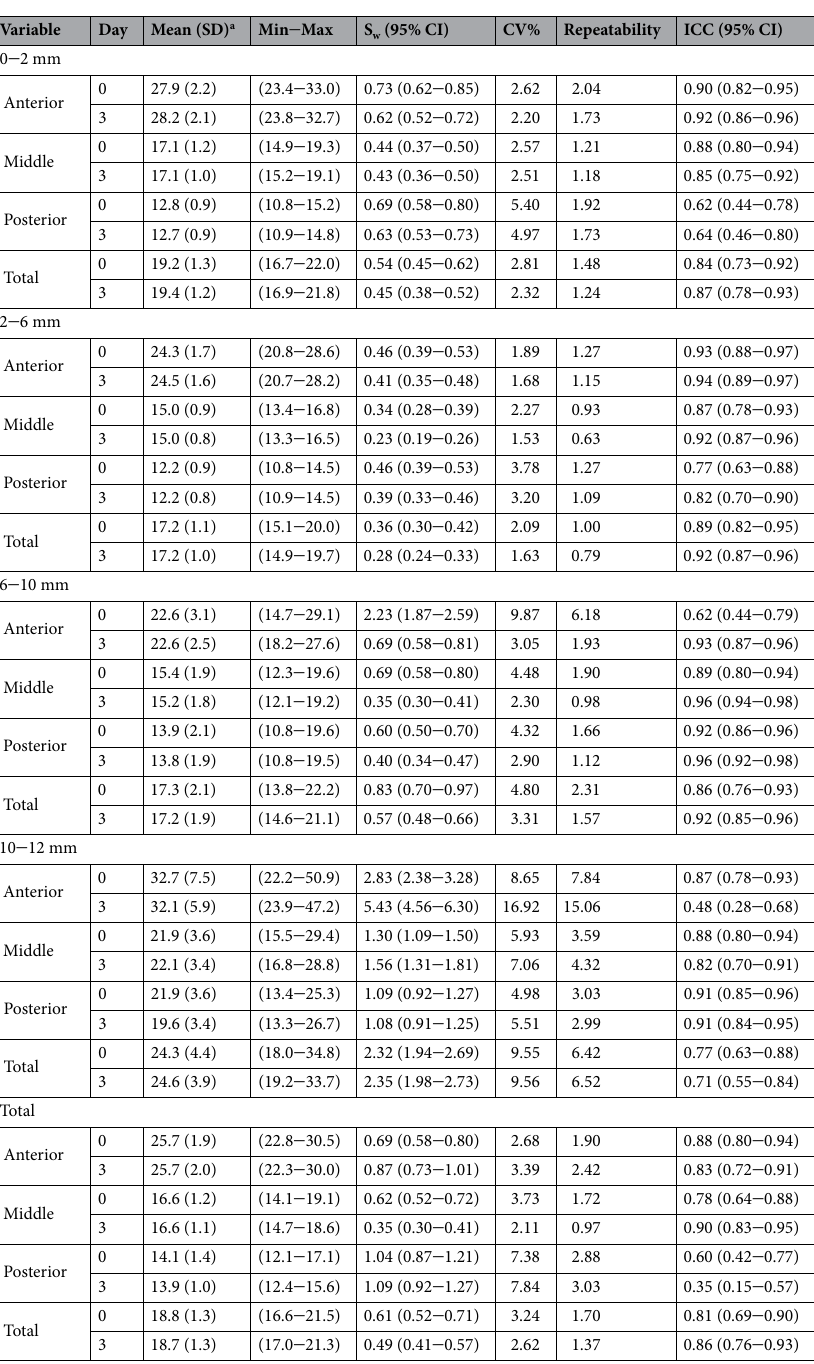
Table 1. Descriptive statistics and repeatability of measurements on Day 0 and Day 3 in subjects with keratoconus. a Subject mean. The values are presented in greyscale units. Standard deviation (SD), S w (Within-subject standard deviation, CI (confidence intervals), CV% (coefficient of variation), ICC (Intraclass correlation